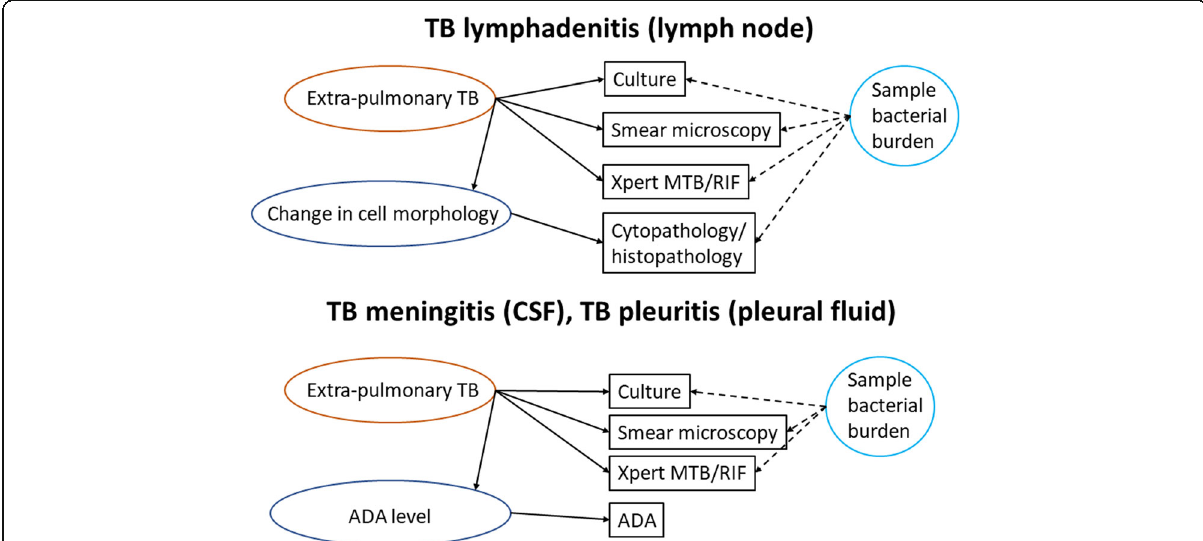
Fig. 1 Heuristic model. The model shows the assumed relationships between latent classes (ovals), diagnostic test results (rectangles), and random effect representing sample bacterial burden (circle). ADA adenosine deaminase, CSF cerebral spin fluid, TB